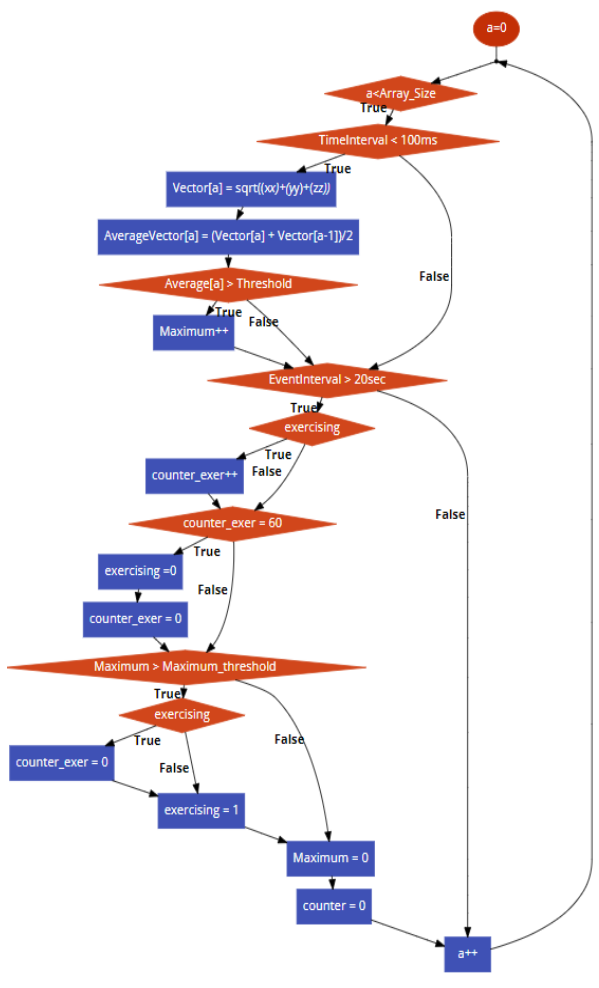
Figure 6. CDA flowchart .